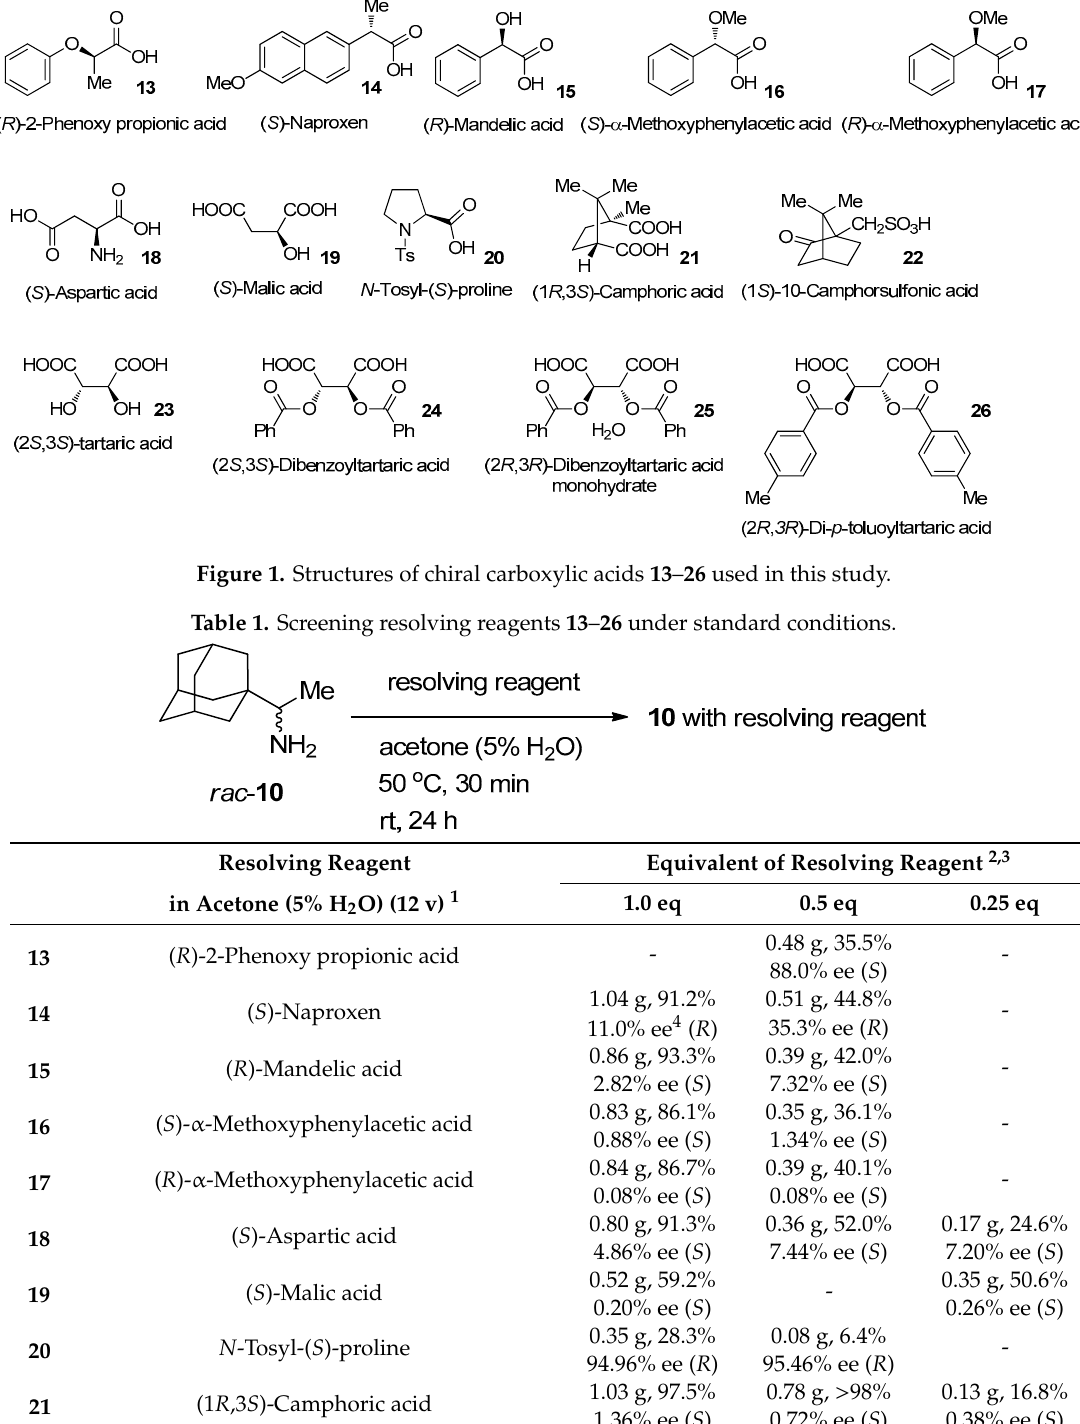
Table 1. Screening resolving reagents 13 – 26 under standard conditions.